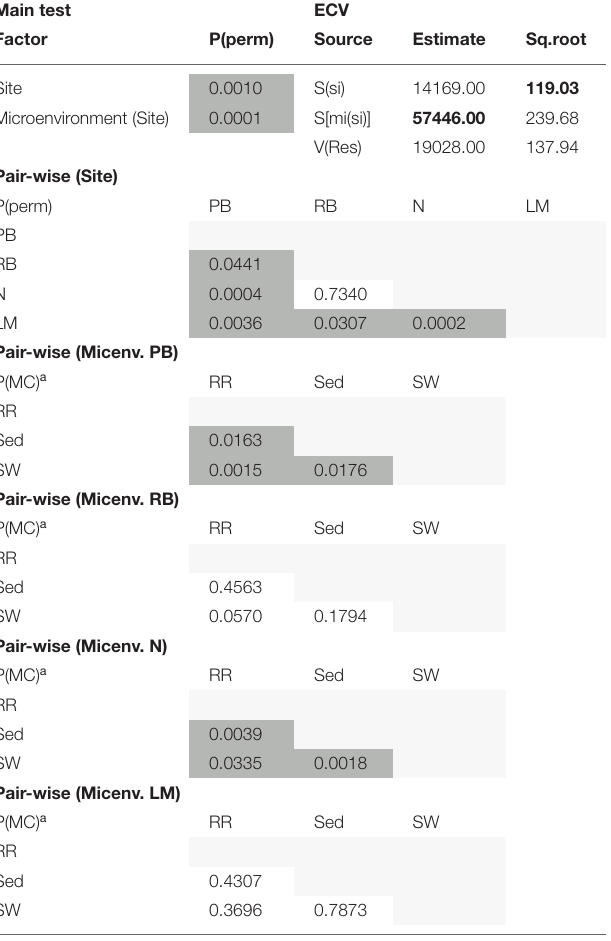
Differences in alpha diversity as measured by Chao1 diversity across sites and microenvironments (main test), between sites and between microenvironments within sites (pair-wise) were tested for statistical significance in Permutational Multivariate Analysis of Variance (PERMANOVA, Minkowski metric distance matrix,